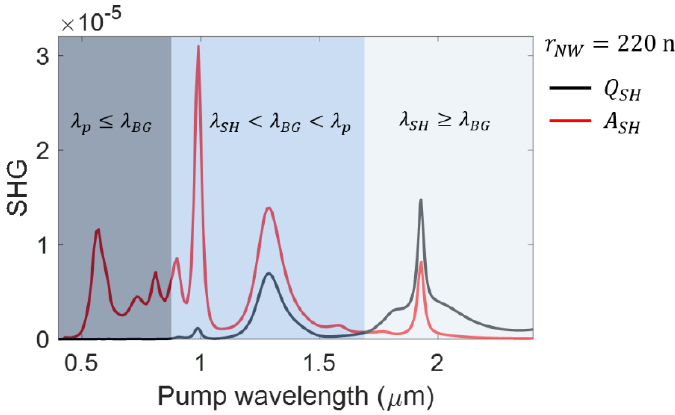
Figure 8. SH scattering and absorption efficiency for a GaAs nanowire with 𝑟 𝑁𝑊 = 220 nm with an input pump intensity 𝐼 𝑝 = 2 GW/cm 2 . The three background colors indicate the three regions described in the text with the same color code of Figure 7.